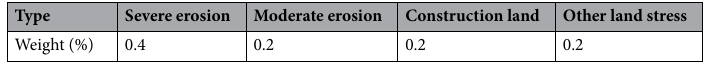
Table 4. Weight of the land stress index